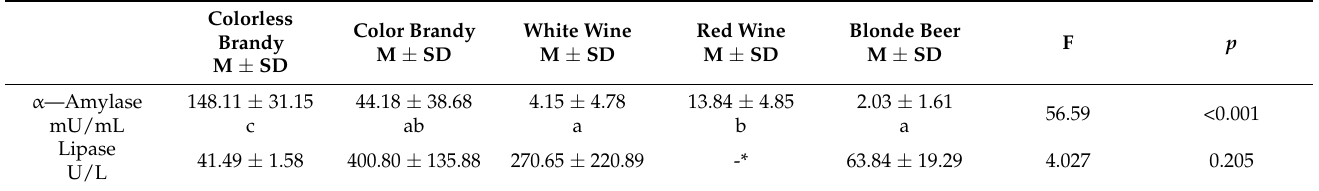
Table 5. Descriptive measurements and univariate effects of enzymatic activity (lipase and α -amylase enzymes) in alcoholic beverages (brandies, wines, and beer).